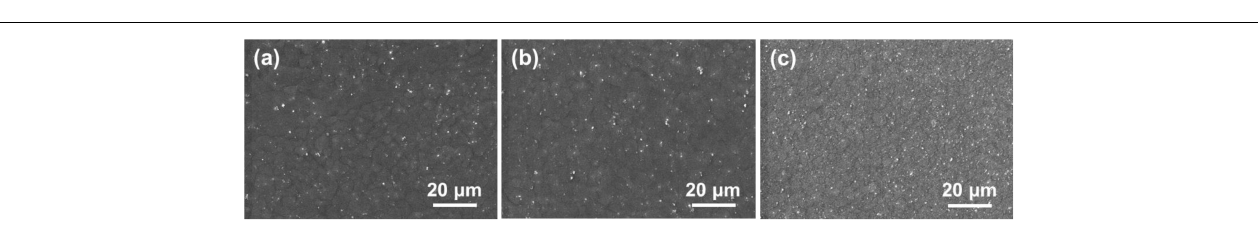
Frontiers in Materials |